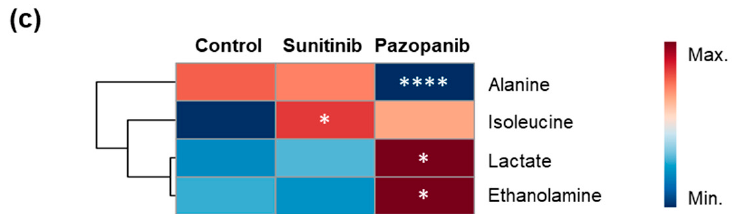
Figure 3. Impact of TKIs on the endometabolome (intracellular metabolites) profile of HK-2 cells. ( a , b ) PLS-DA scores scatter plots (left) and loading plots (right) obtained for ( a ) non-exposed cells (green circles, n = 4) vs. cells exposed to 2 µM sunitinib (yellow circles, n = 4) and ( b ) non-exposed cells (green circles, n = 4) vs. cells exposed to 50 µM pazopanib (blue circles, n = 4). ( c ) Heatmap illustrating the mean levels of intracellular metabolites changing in HK-2 cells after exposure with 2 µM sunitinib and 50 µM pazopanib. Rows correspond to the mean normalized peak area of each metabolite colored from minimum value (dark blue) to maximum value (dark red), while the columns represent each sample group. The control group represented in the first column corresponds to non- exposed cells. The statistical significance was assessed by comparison with the control cells (* p < 0.05, **** p < 0.0001). Abbreviations: Ala—alanine, ETA—ethanolamine, GPC—glycerophosphocholine, Iso—isoleucine, PC—phosphocholine. Table 1. List of metabolites significantly altered in the endometabolome of Caki-1 and HK-2 cells after exposure with 2 µM sunitinib or 50 µM pazopanib in comparison with the corresponding non- exposed cells (control).